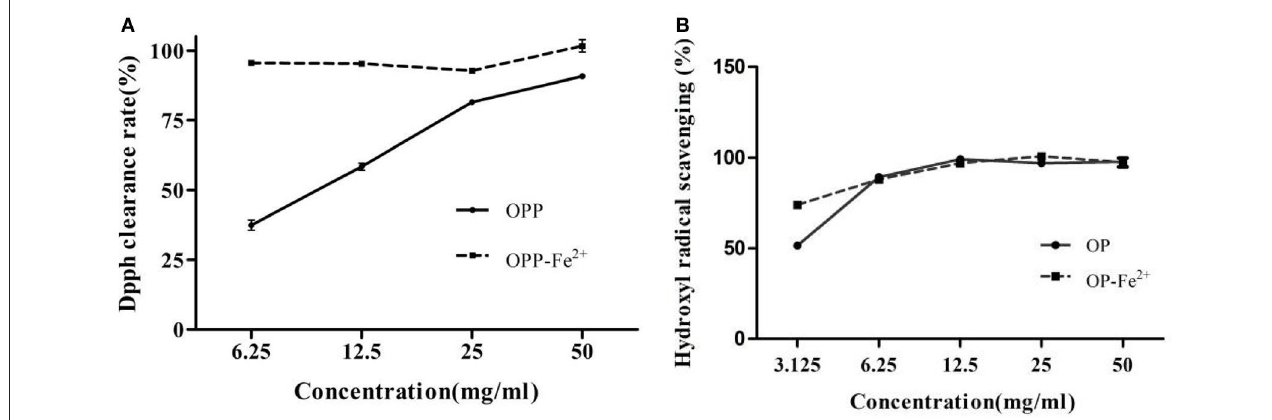
FIGURE 3 | The antioxidant activities of the OP and OP-Fe 2 + (A) DPPH free radical scavenging activity and (B) hydroxyl radical scavenging activity.